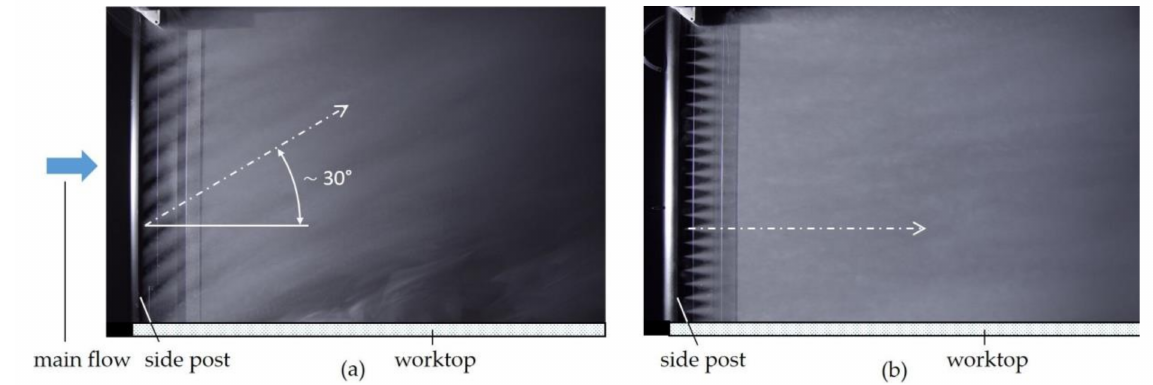
Figure 22. Jet direction: ( a ) baseline directed obliquely upwards and ( b ) improved nozzle design with horizontal